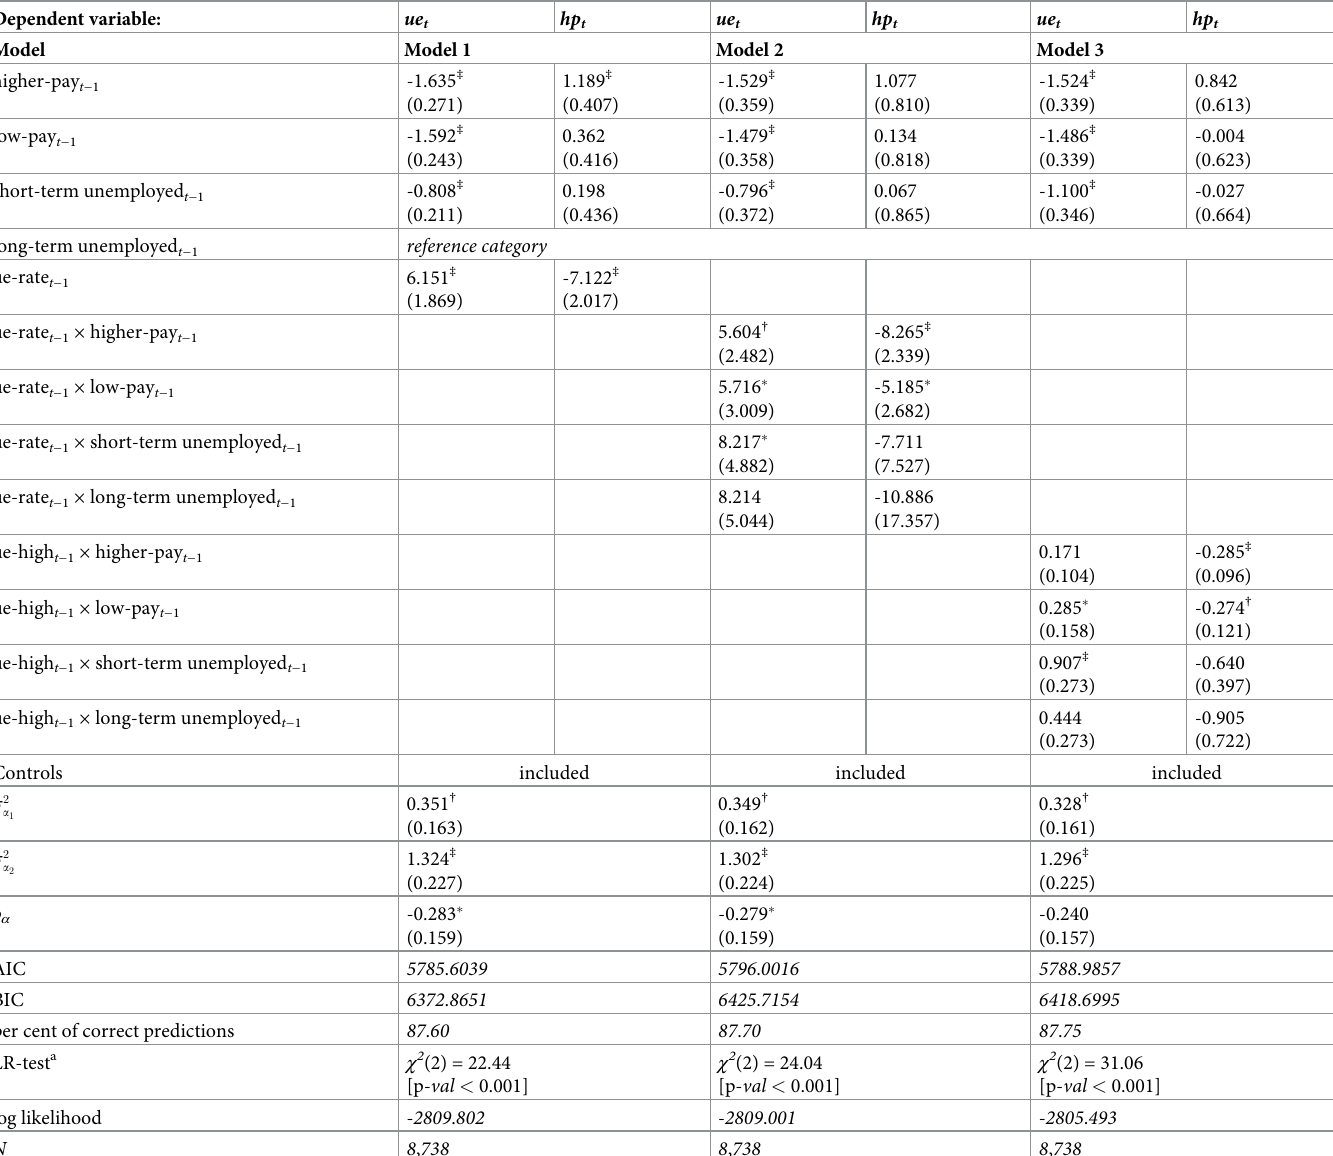
Table 3. Correlated random effects probit regression of lagged labour market position on current labour market